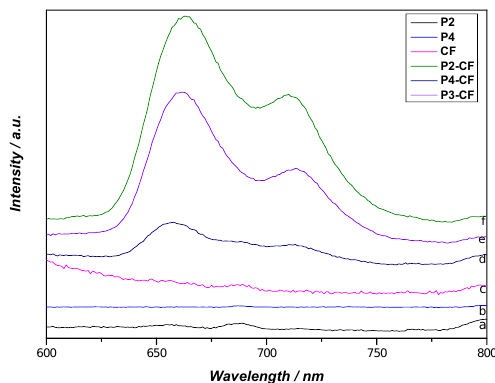
Int. J. Mol. Sci. 2019 , 20 , x